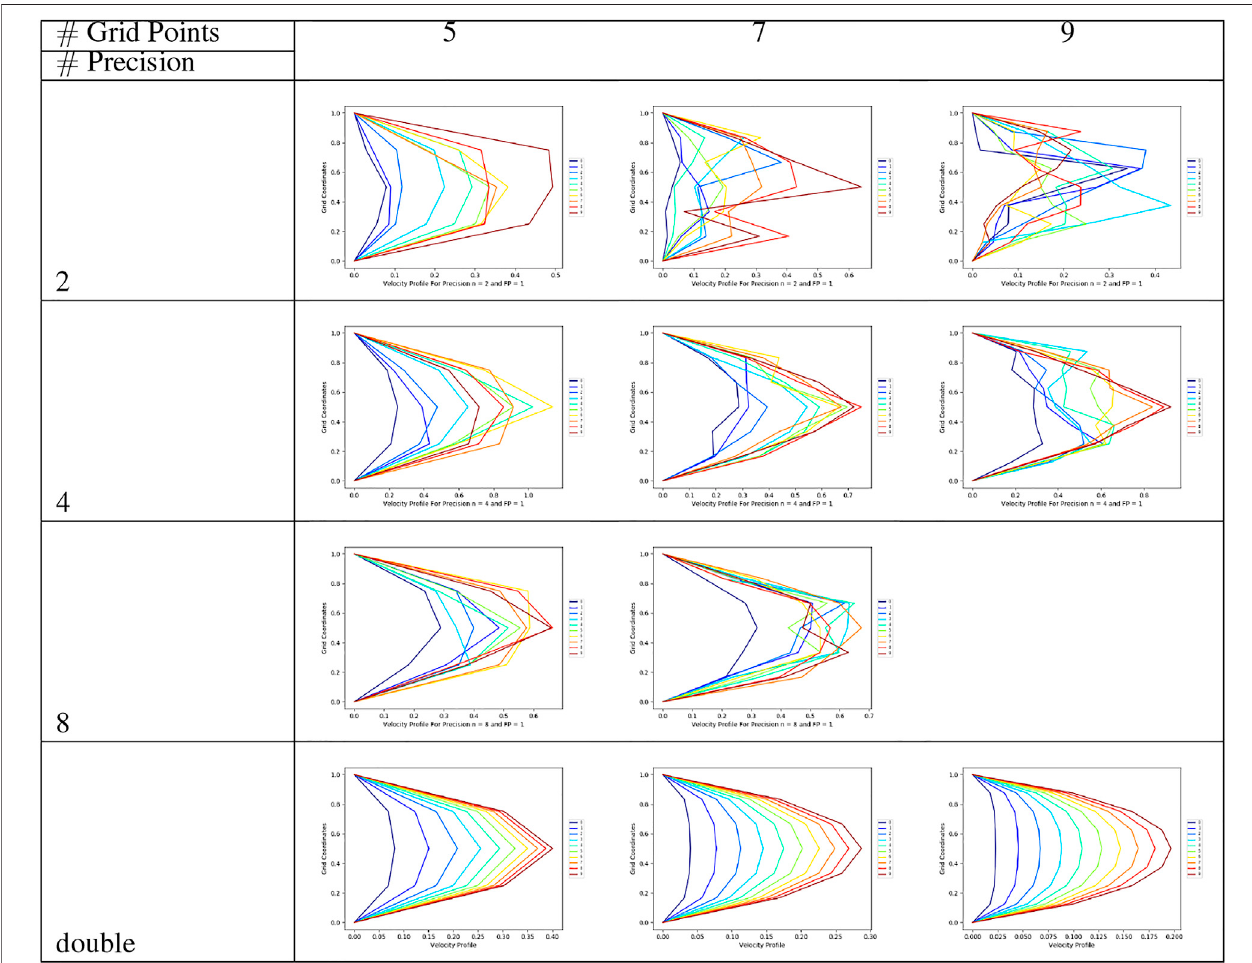
FIGURE 6 | Solution pro fi les corresponding to weighted mean state for precision ’ s 2, 4, 8 and double for mesh with sizes 5, 7 and 9.